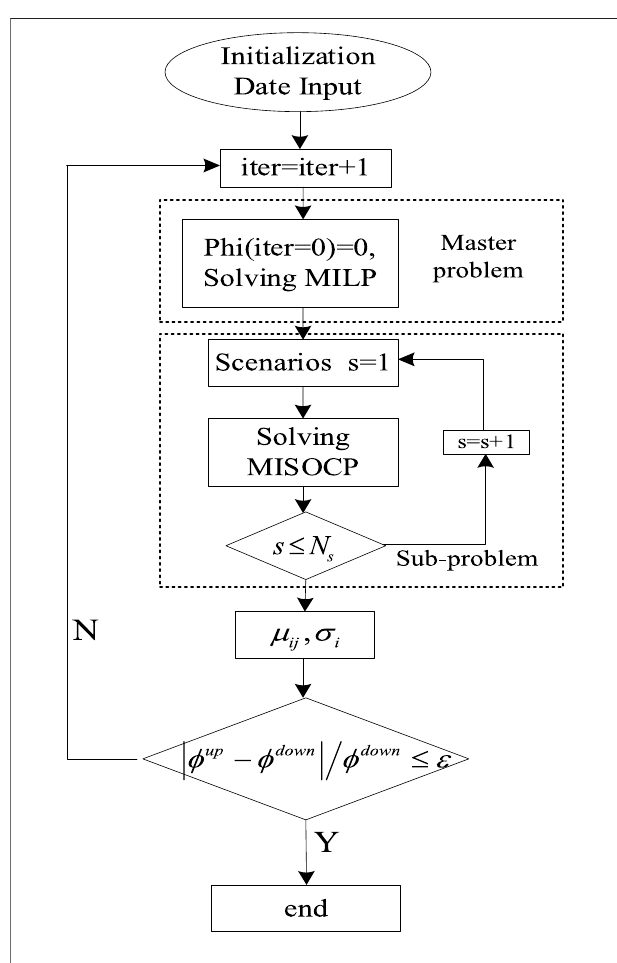
FIGURE 6 | Flowchart of the Benders decomposition